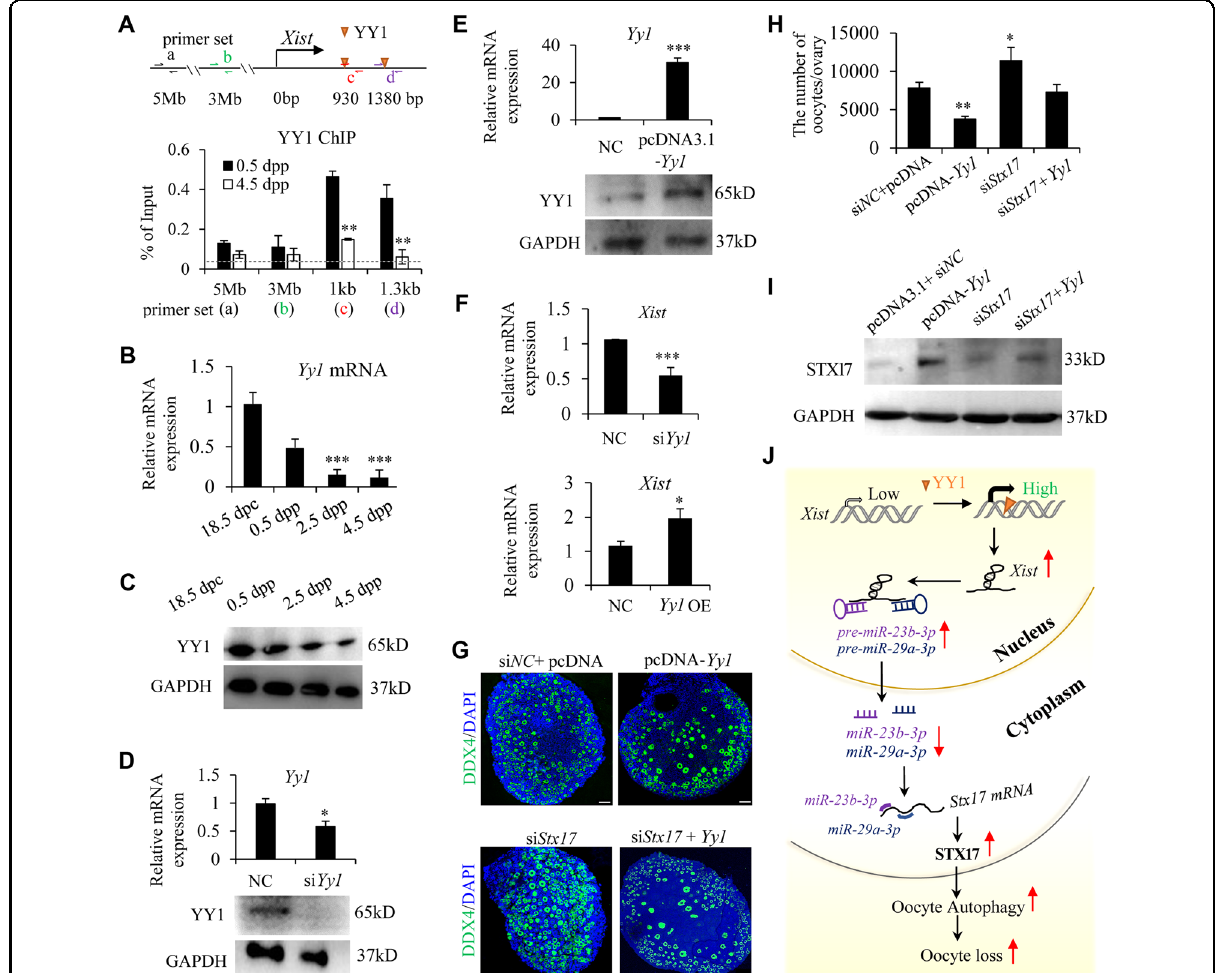
Fig. 6 YY1 is essential for Xist expression and functions as an upstream regulator for Xist - miR-23b-3p / miR-29a-3p- Stx17 axis during PF formation. a Schematic representation for YY1 binding motif within the proximal promoter region of Xist , with respective primer sets to amplify YY1 binding region. The upstream control region is also represented (top). Bottom: ChIP analysis of YY1 binding in newborn mouse ovaries at 0.5 dpp, and 4.5 dpp. The dashed line represents the basal IgG binding. b , c Relative Yy1 mRNA ( b ), and YY1 protein ( c ) expression in perinatal ovaries at indicted time. d , e Relative Yy1 mRNA (top), and YY1 protein (bottom) expression in cultured newborn ovaries transfected with si Yy1 or control ( d ), pcDNA3.1- Yy1 , and NC control ( e ). f Relative Xist mRNA expression in cultured newborn ovaries transfected with si Yy1 or siRNA control (top), pcDNA3.1- Yy1 or NC control (bottom). g , h Representative DDX4 immuno fl uorescence images ( g ) and quanti fi cation of follicles ( h ) in newborn ovaries transfected under indicated condition. Scale bars: 50 μ m. i WB analysis of STX17 expression in newborn ovaries treated under indicated condition. j Proposed model for Xist - miR-23b-3p / miR-29a-3p- STX17 axis in regulating oocyte loss in the perinatal mouse ovaries. Student ’ s t -test: * P < 0.05, ** P < 0.01, *** P <